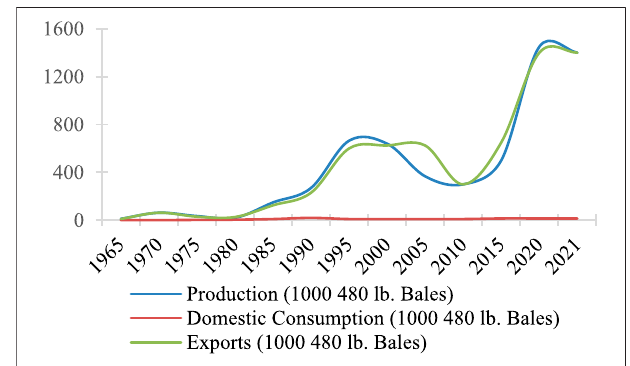
FIGURE 1 | Cotton yield and agricultural land in Benin. Source: Authors with data from USDA, https://apps.usda.gov/psdonline.